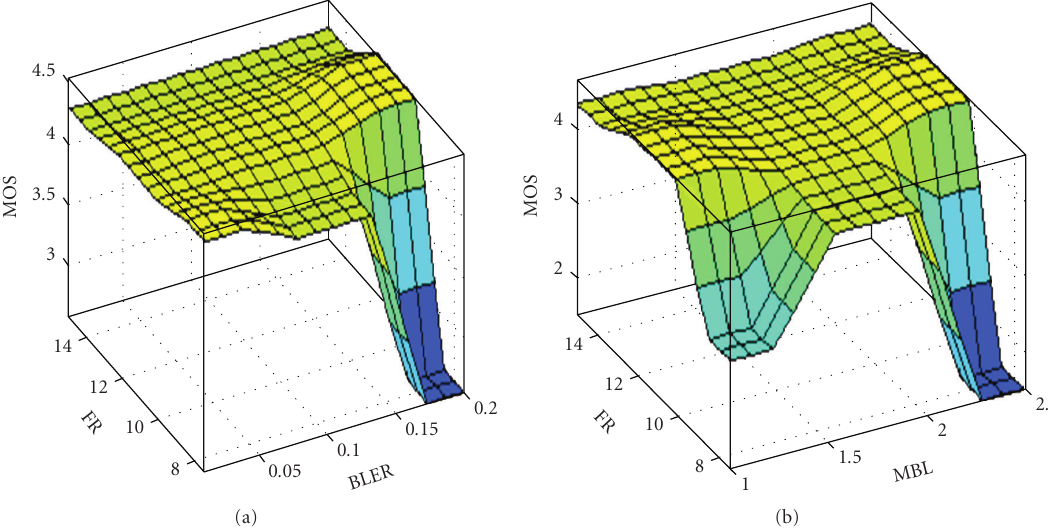
Figure 16: (a) MOS versus FR versus BLER. (b) MOS versus FR versus